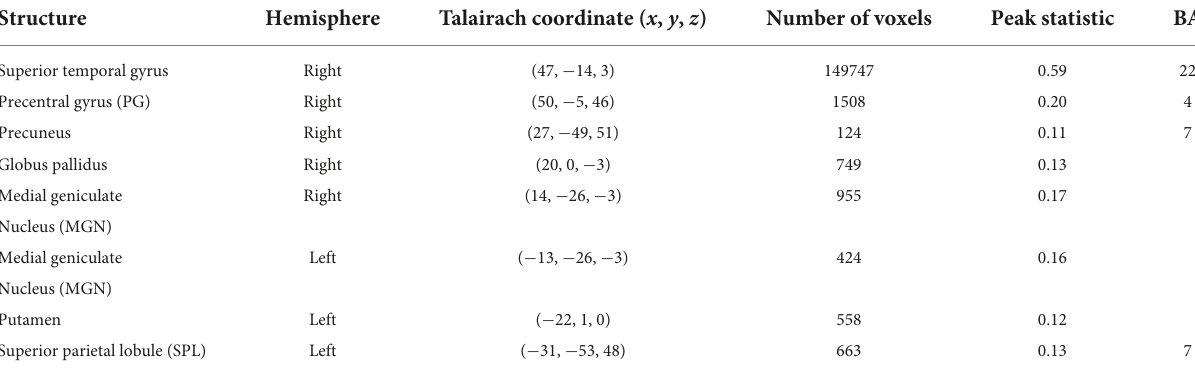
TABLE 1 Results of the inter-subject correlation (ISC) analysis for watching and listening to the point-light string